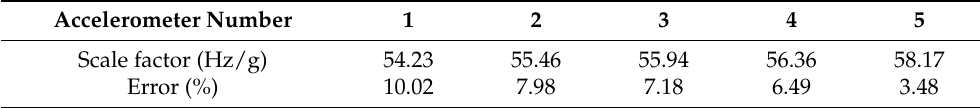
Figure 8. Packaged accelerometer and closed-loop circuits. Table 3. Scale factor and e rror of packaged accelerometers.